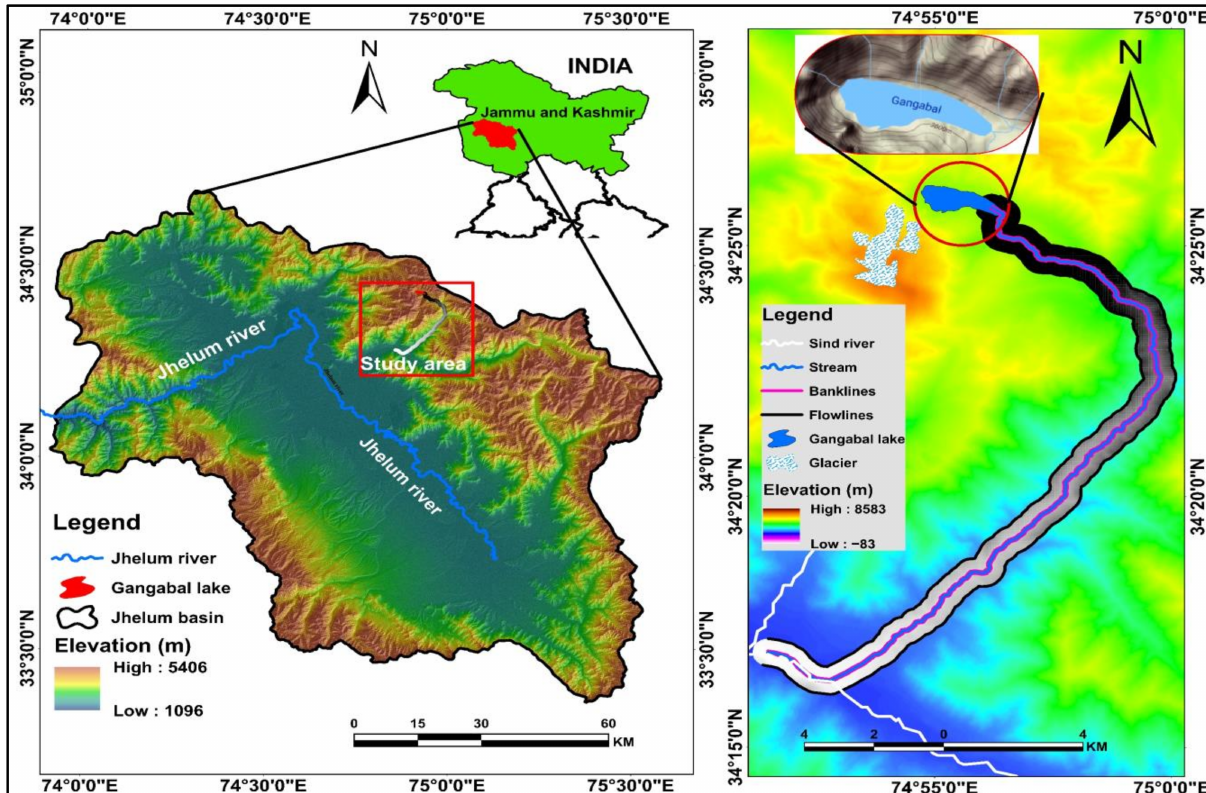
Figure 2. Location map of the study